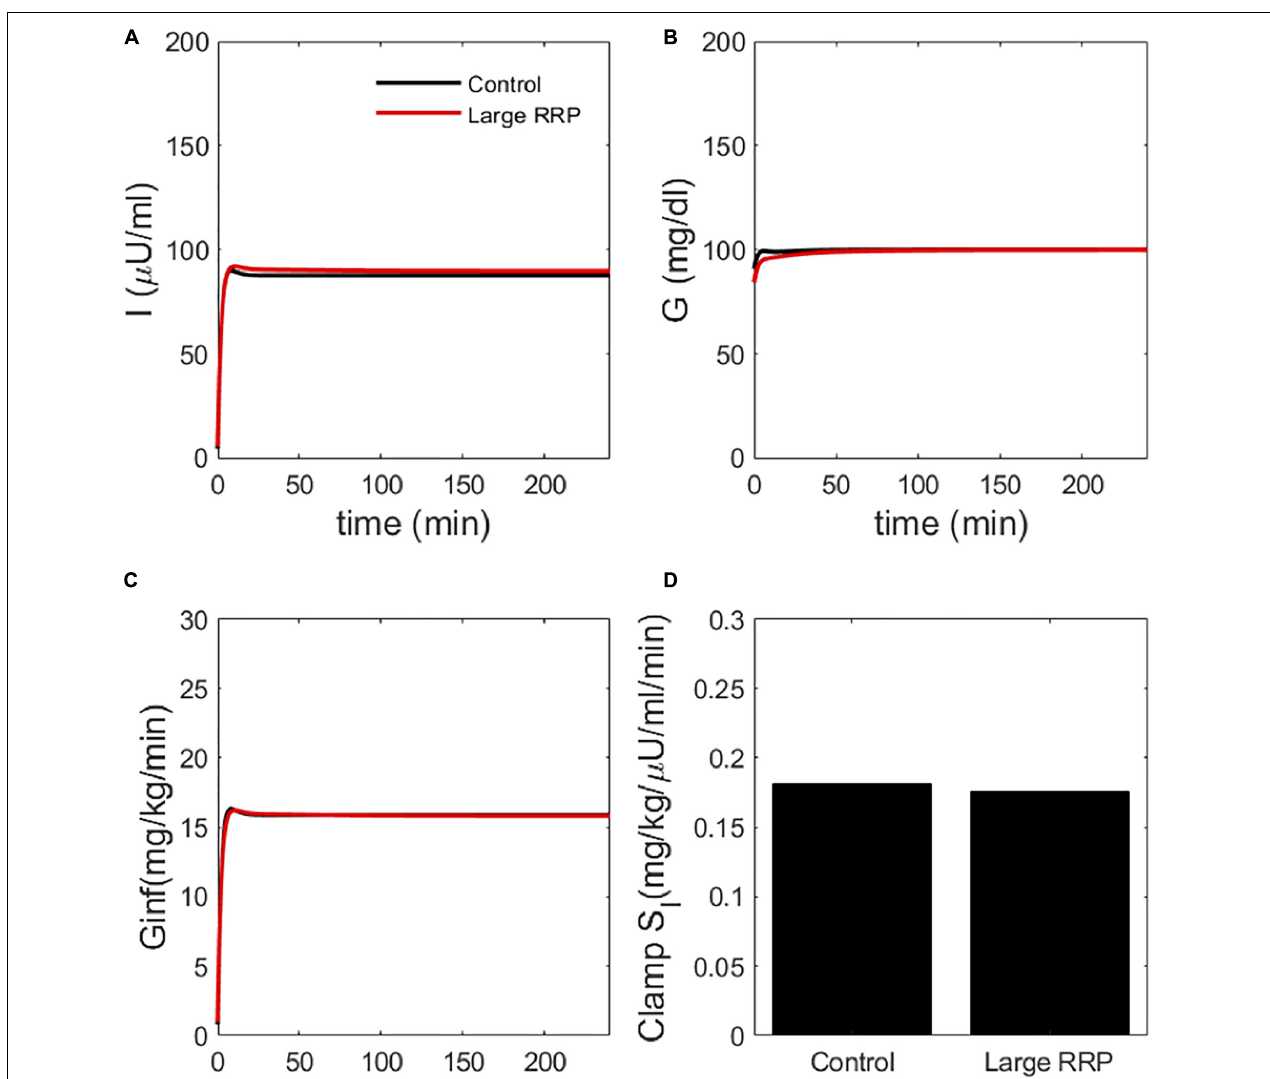
FIGURE 4 | Simulated clamp (HIEC) showing (A) insulin, (B) glucose, (C) glucose infusion rate G inf and (D) insulin sensitivity (Clamp S I ) obtained by normalizing infusion rate by insulin. Control and Large RRP have the same parameters as Figure 2 .